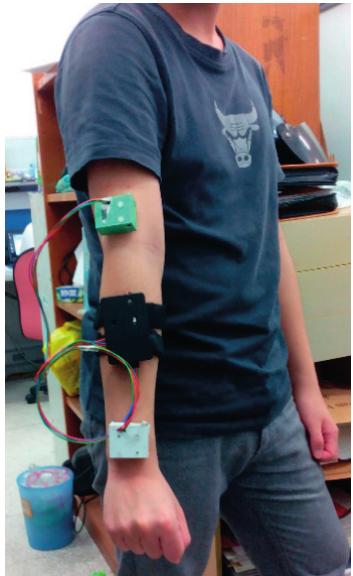
Figure 1. Implemented two-channel wireless IMU system mounted on the upper extremity of a healthy